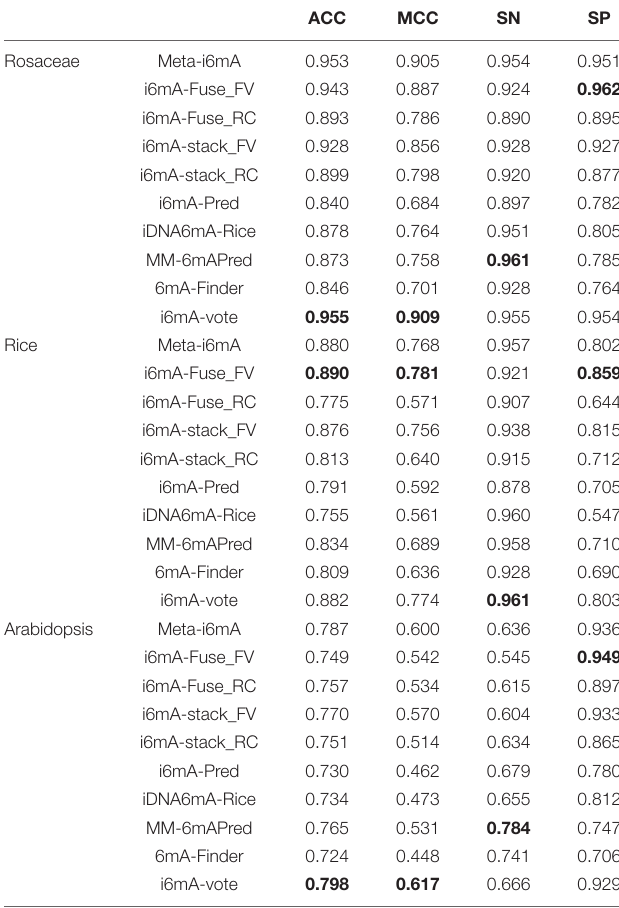
TABLE 3 | Comparison with other machine learning models on Rosaceae, Rice, and Arabidopsis. ACC MCC SN